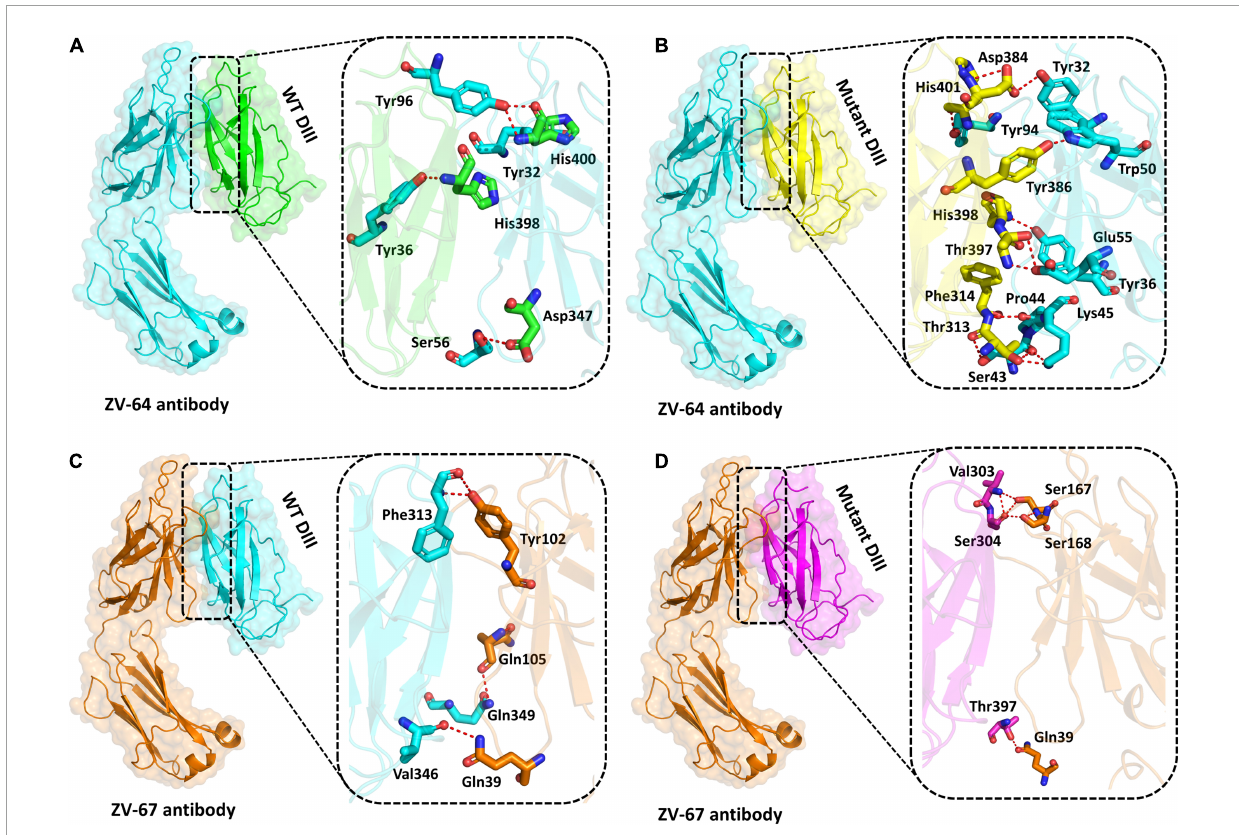
FIGURE4 Docking of wild-type and mutant DIII with ZV-64 and ZV67 neutralizing antibodies. (A) Docking of wild-type DIII with ZV-64 neutralizing antibody. (B) Docking of mutant DIII with the ZV-64 neutralizing antibody. (C) Docking of wild-type DIII with the ZV-67 neutralizing antibody (DIII). (D) Docking of mutant DIII with ZV-67 neutralizing antibody.